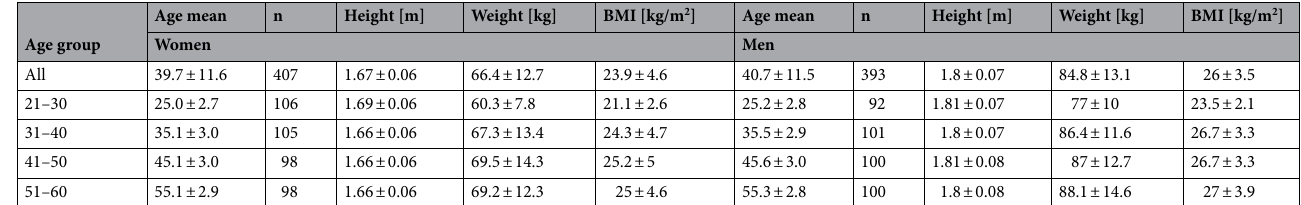
Table 1. Biometric distribution of the investigated